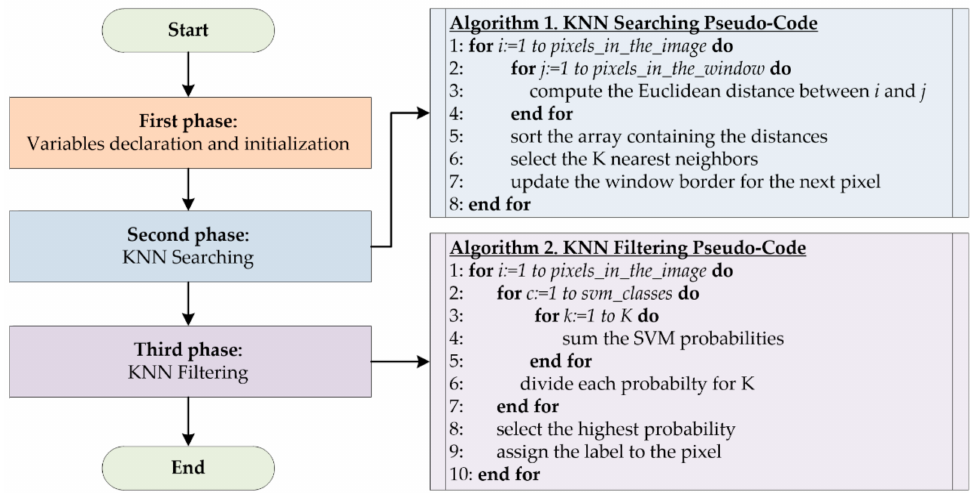
Figure 5. Flow diagram of the serial implementation of the KNN filtering